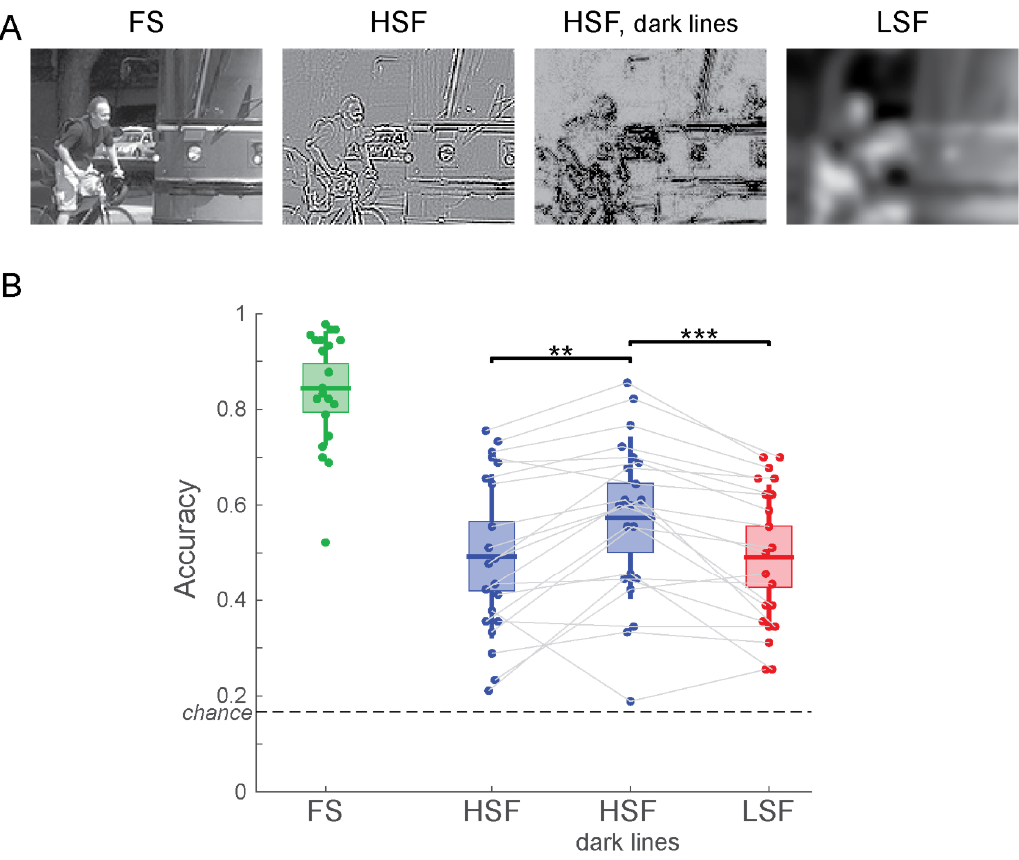
Figure 5. ( A ) Example stimuli for Experiment 3. ( B ) Accuracy of scene categorization for Experiment 3. ** p < 0.01; *** p <